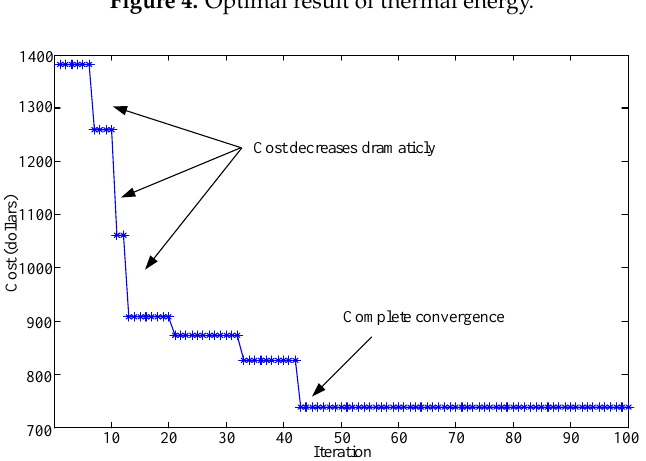
Figure 4. Optimal result of thermal energy.